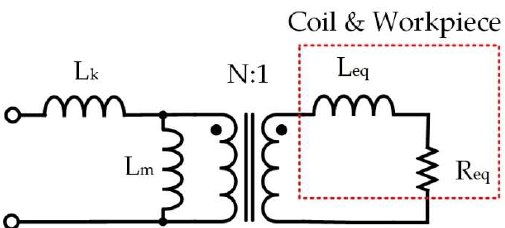
Figure 9. Equivalent simplified model of a heating coil and workpiece combined with a transformer.